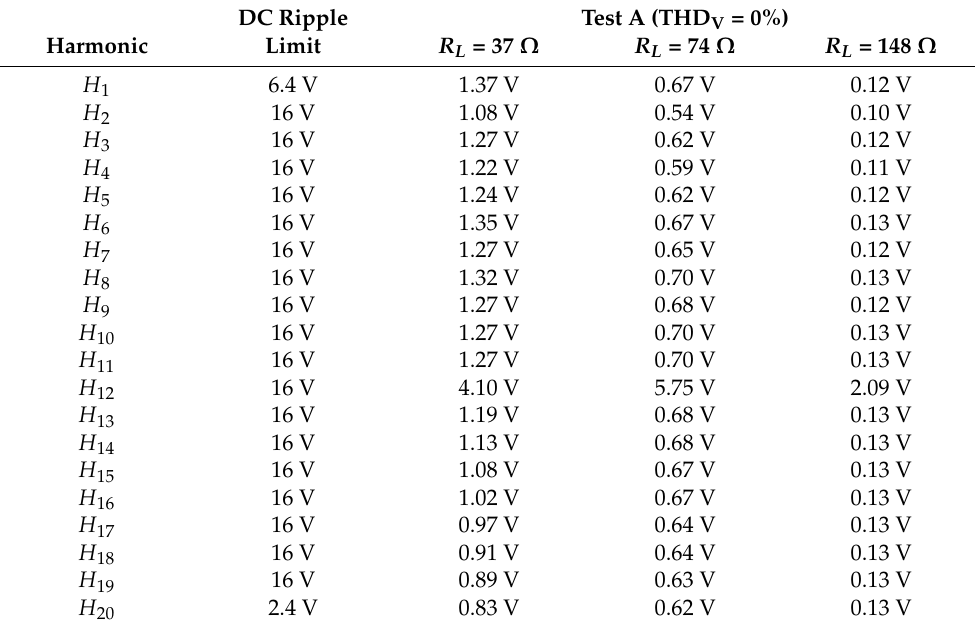
Table 11. The harmonic content of CTU output voltage.